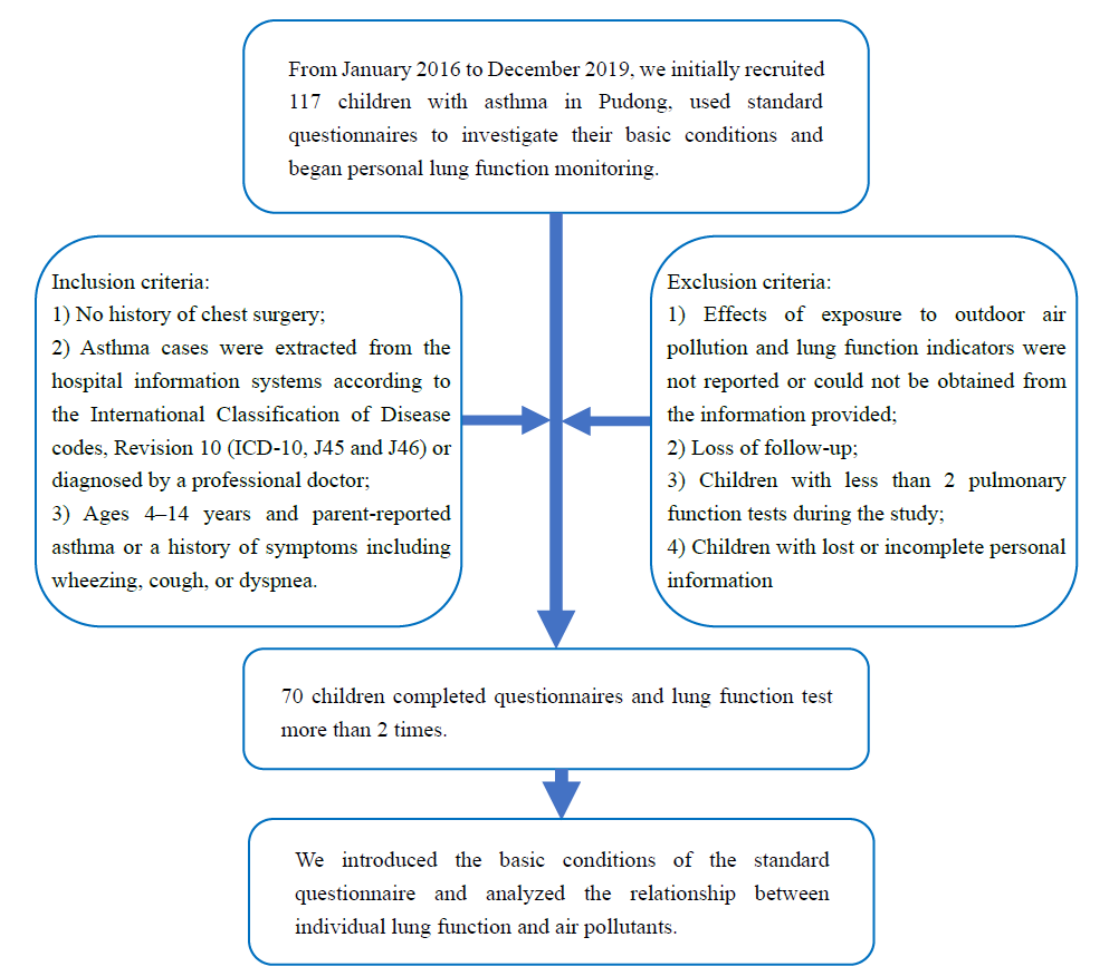
Figure 1. The selection of the participants in this study.